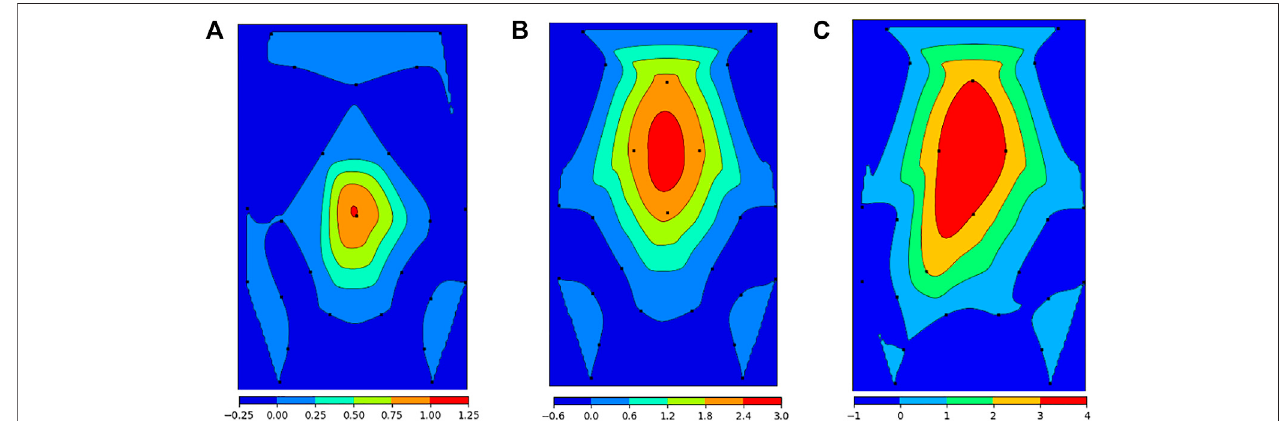
FIGURE 9 | Contour region areas correlated with applied force. (A) 3N applied force, (B) 6N applied force, (C) 12N applied force.